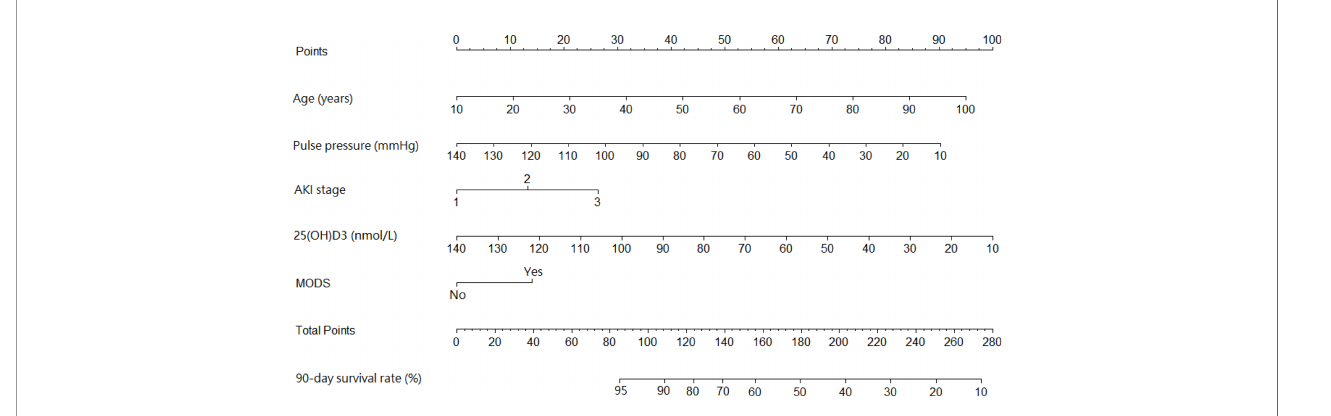
FIGURE 1 | Nomogram predicting the 90-day survival rate in diabetic patients with acute kidney injury